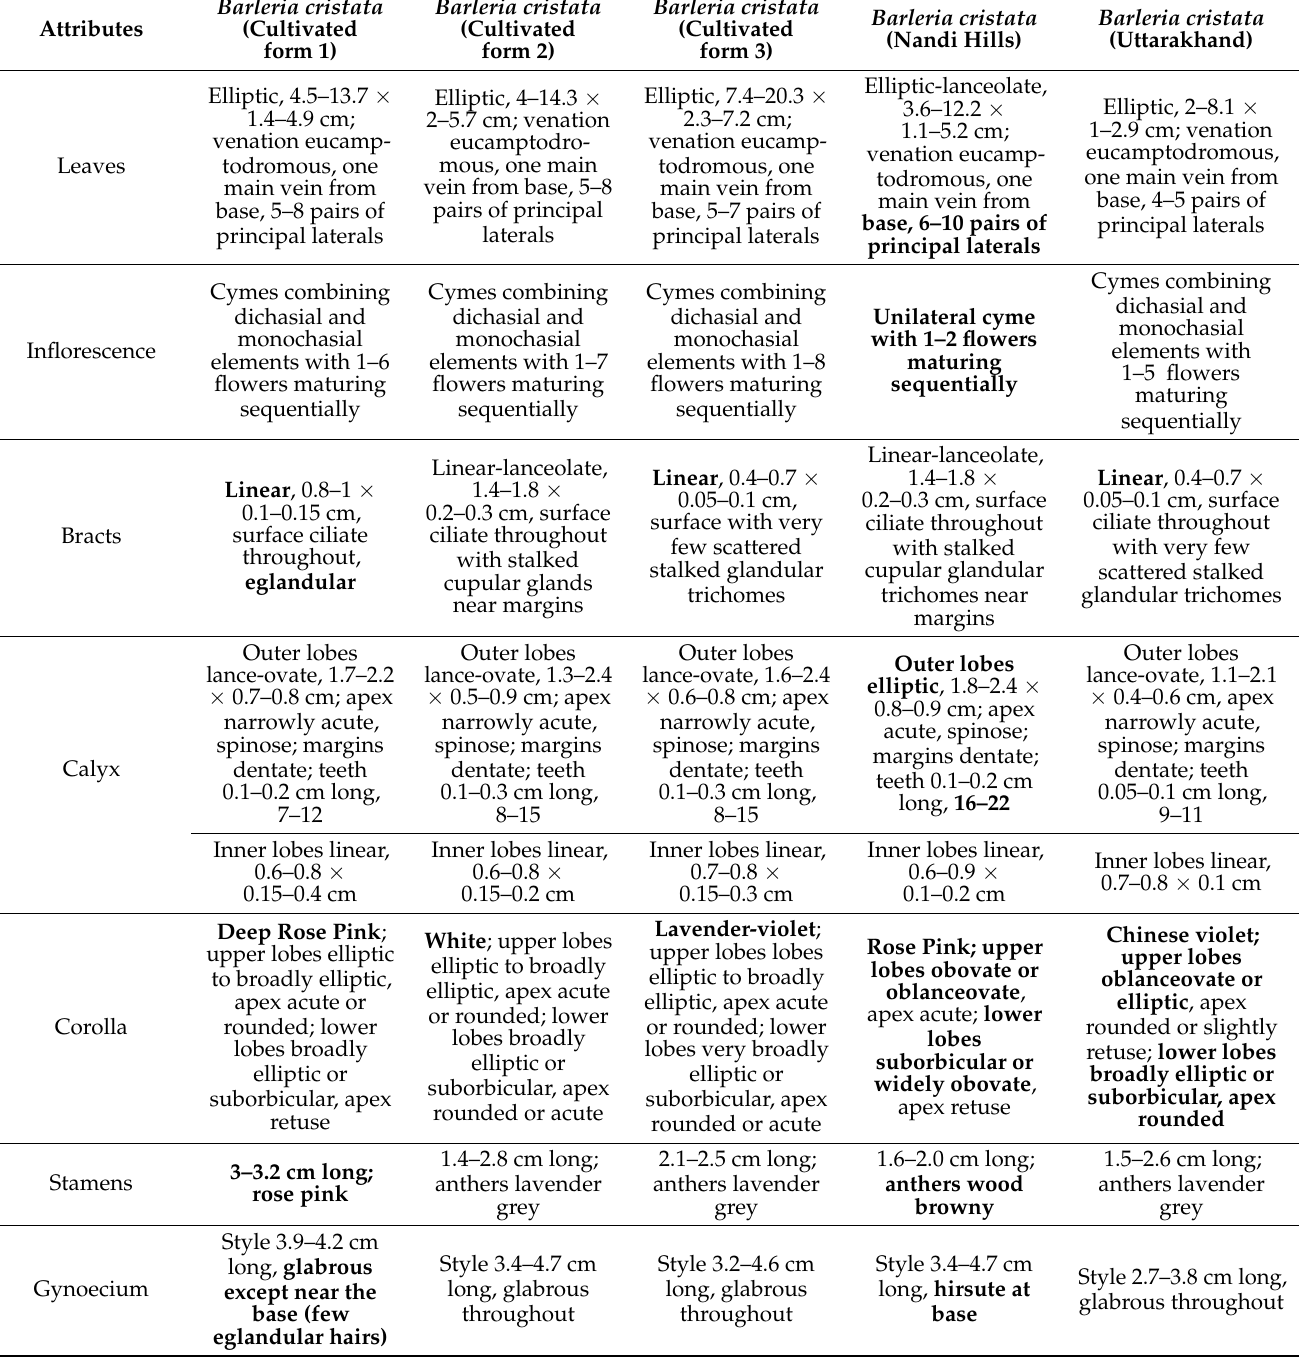
Table 2. Comparative morphology of Barleria cristata morphotypes. Variable characters indicated in